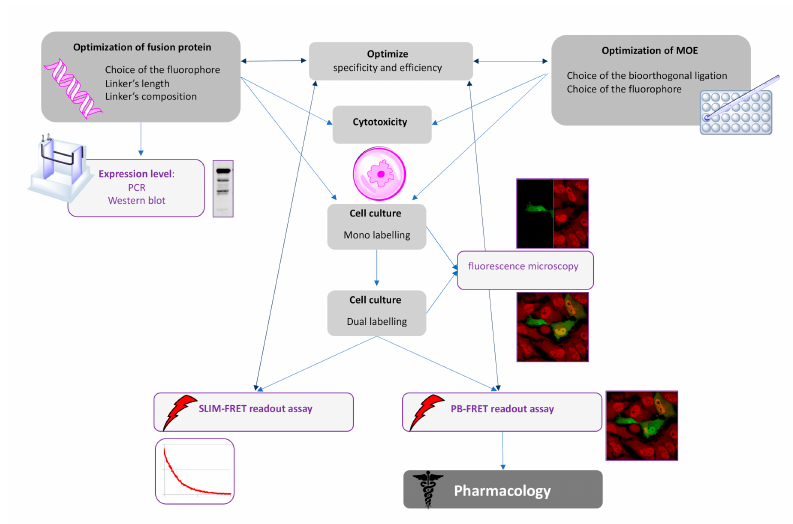
Figure 7. Flowchart demonstrating how to combine the technologies for FRET-based imaging of dual-labeling of